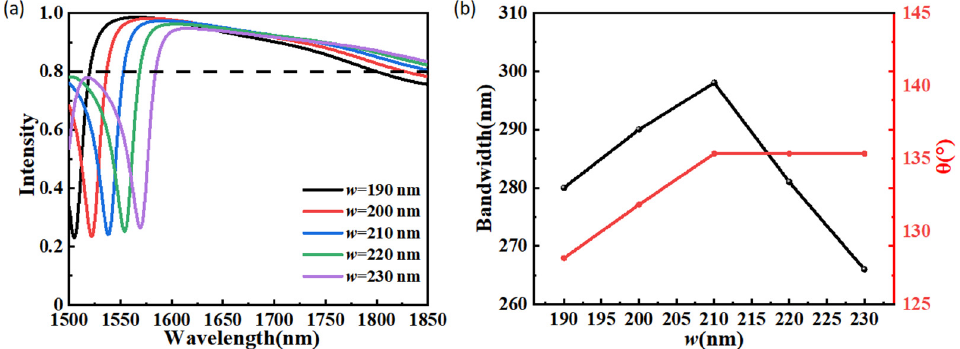
Figure 6. ( a ) The anomalous transmission intensity at different values of w within the wavelength range of 1500–1850 nm. ( b ) Operating bandwidth and the maximum beam split angle in the operating bandwidth as a function of the structure parameter w .